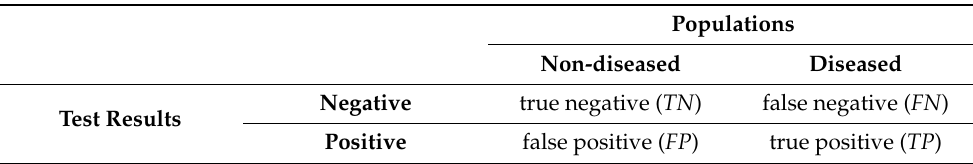
Figure 1. Probability density function plots. The probability density functions plots of a measurand in a non-diseased and diseased population. Table 1. A 2 × 2 contingency